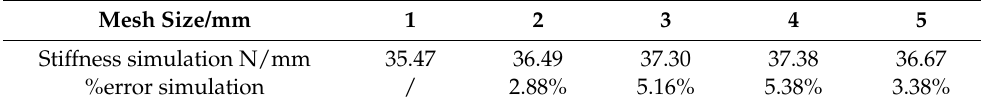
Table 2. Stiffness simulation results for different mesh